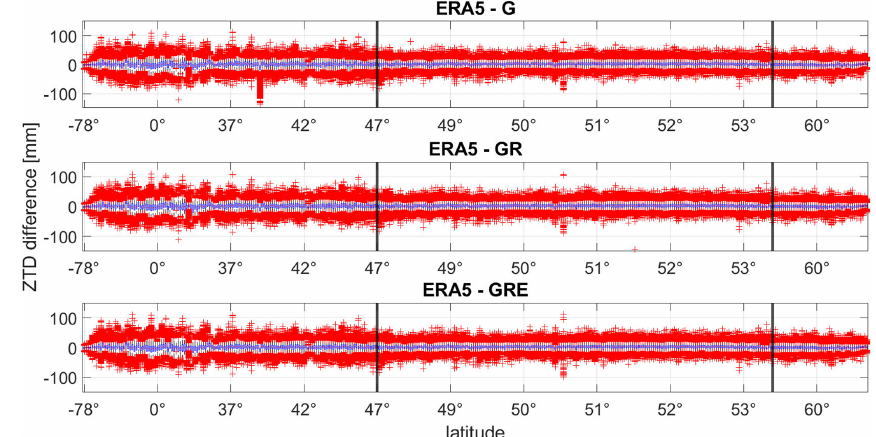
Figure 5. The box plots of the ZTD differences between ERA5 and three GNSS solutions for each station. The blue boxes denote the 25th and 75th percentile. The median is marked inside the boxes. The red crosses denote outliers. The stations are sorted by latitude, and the black lines indicate the latitude band that includes Germany. Please note that the labeling of the x axis is non-equidistant. The values are calculated for the year 2020.